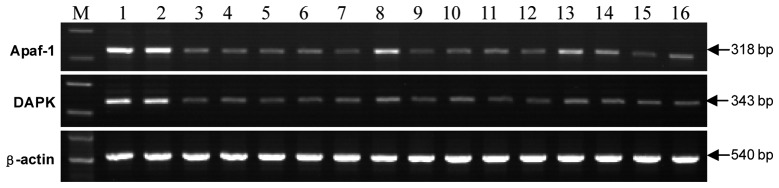
Representative examples of RT-PCR analyses of Apaf-1, DAPK and β-actin. Lanes 1 and 2 show samples of normal oral mucosa. Lanes 3–16 show samples of OSCC. RT-PCR, reverse transcription polymerase chain reaction; Apaf-1, apoptosis protease activating factor-1; DAPK, death-associated protein kinase; OSCC, oral squamous cell carcinoma; M, DL2000 Marker.